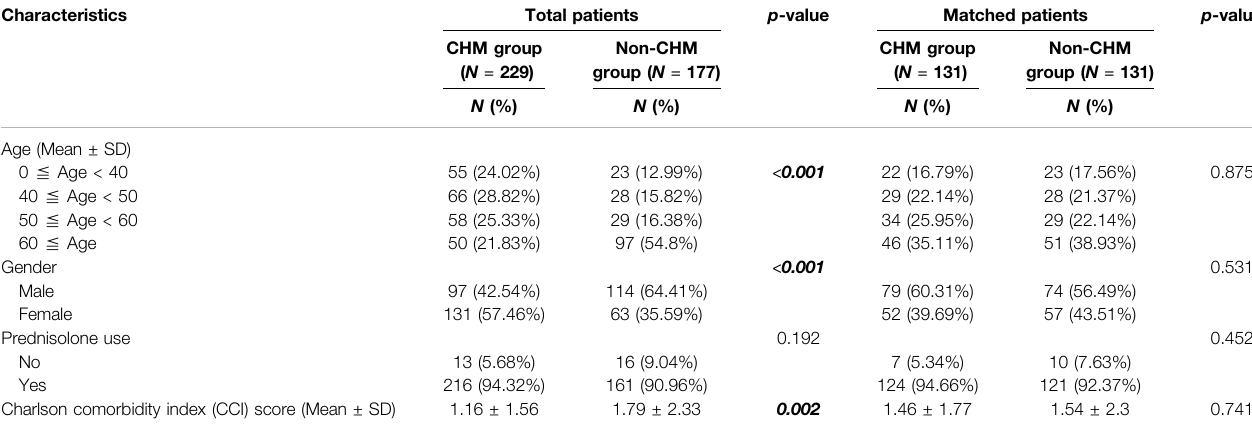
TABLE 1 | Demographic characteristics between CHM and non-CHM groups among patients with pemphigus in Taiwan.